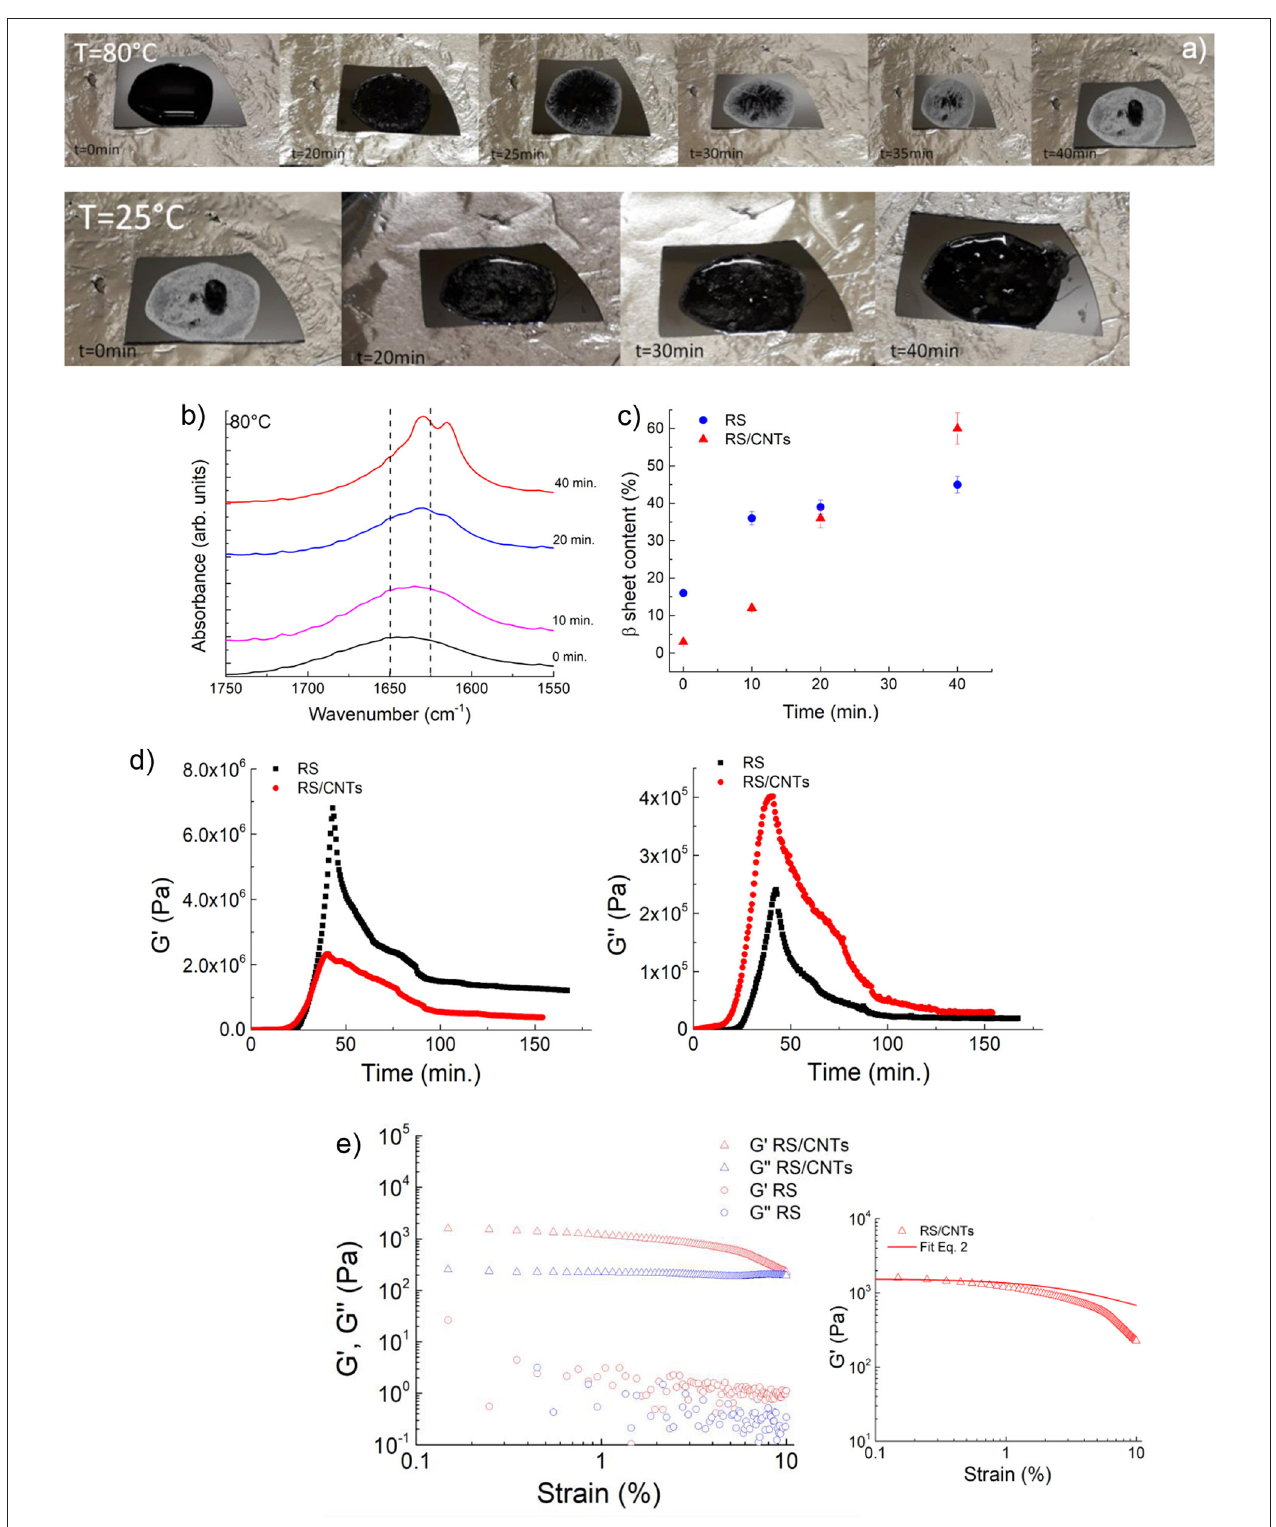
FIGURE 2 | (a) Photos showing the reversible liquid-solid transition observed along the heating/cooling time of RS/CNTs. (b) ATR-FTIR spectra in the amide I region for RS/CNTs liquid solution annealed at 80 ◦ C at different times. (c) Annealing time effect on β -sheet content at 80 ◦ C assessed by FTIR amide I band analysis for